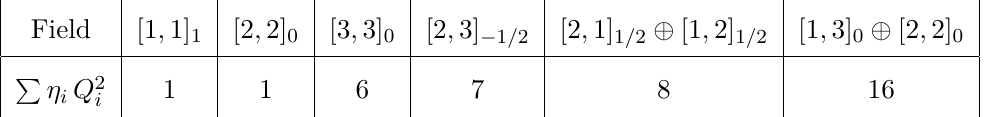
= 1 . The first four entries max